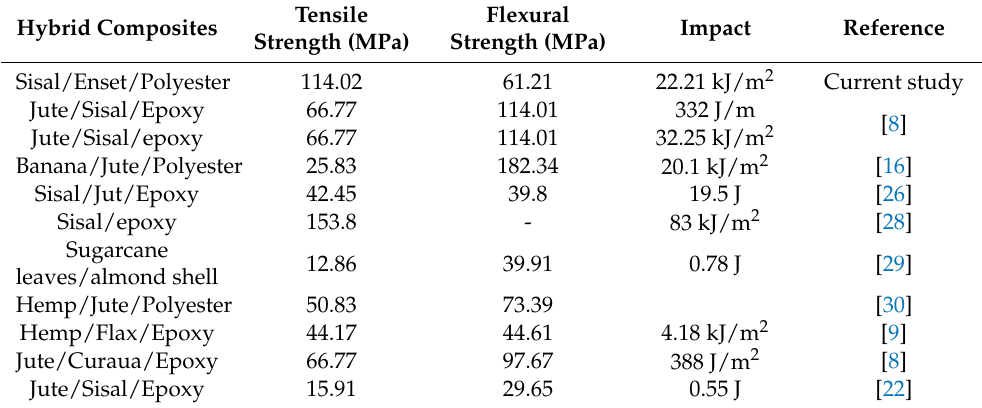
Table 2. Comparison of mechanical properties of natural fiber hybrid composites of the current study with existing literature results.